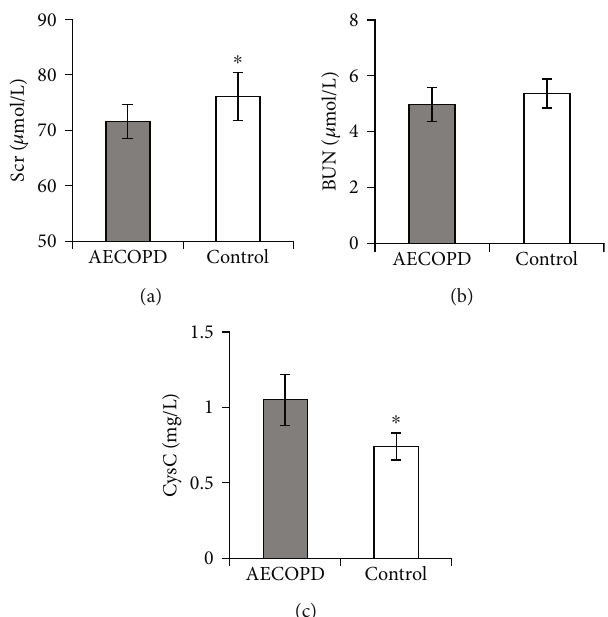
Figure 3: Comparison of renal function indicators in blood routine in patients. Note: (a) Scr; (b) BUN; (c) CysC; there was signi fi cantly distinct from AECOPD group, ∗ P < 0 : 05